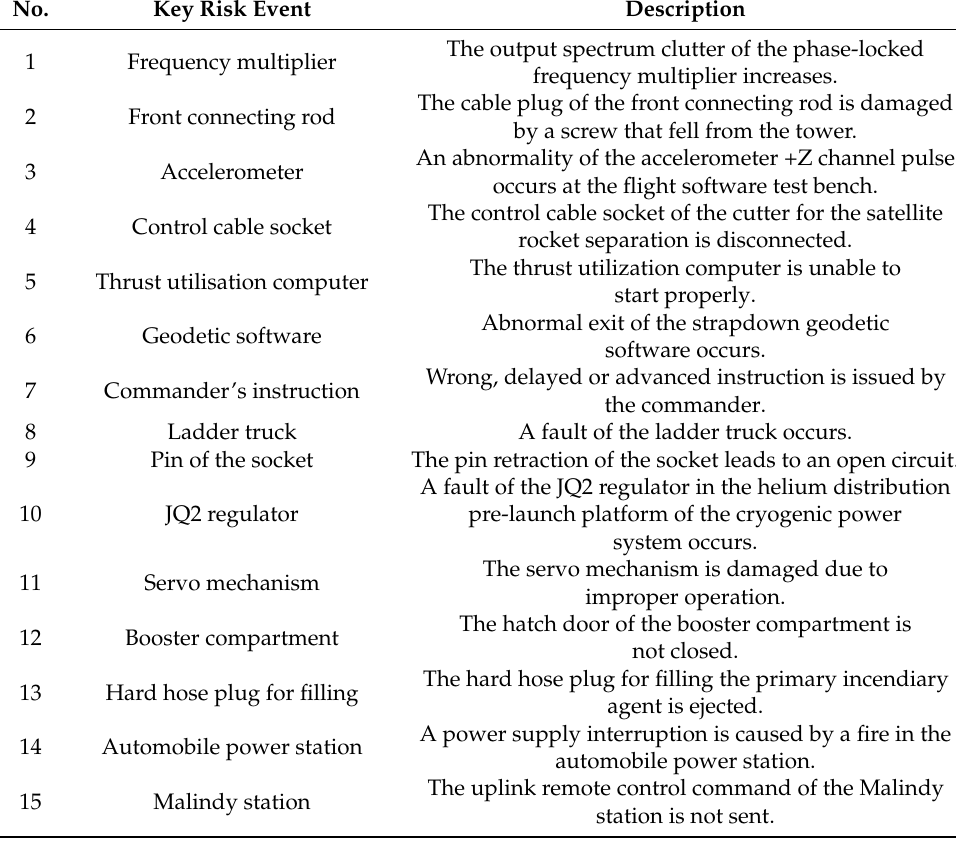
Table 2. Key risk events and their